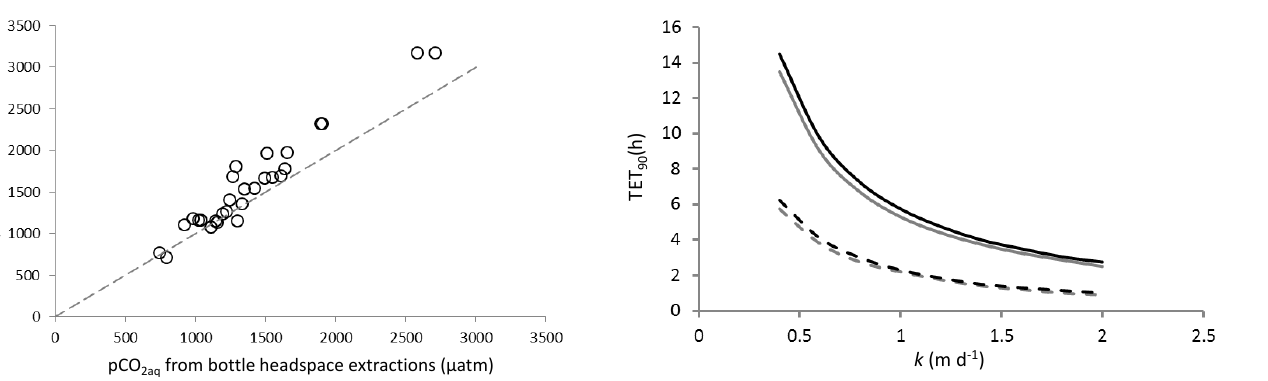
Figure 5. Comparison between instantaneous daytime measure- ments from p CO 2aq chambers (allowed to reach equilibrium) and traditional bottle headspace extractions (1025mL total volume, 50mL headspace, not corrected for enclosing a limited amount of inorganic carbon in the bottle; see text). R 2 for a linear regression is 0.94. The dashed line is the 1 : 1 line (see text for discussion of the deviation from this line).